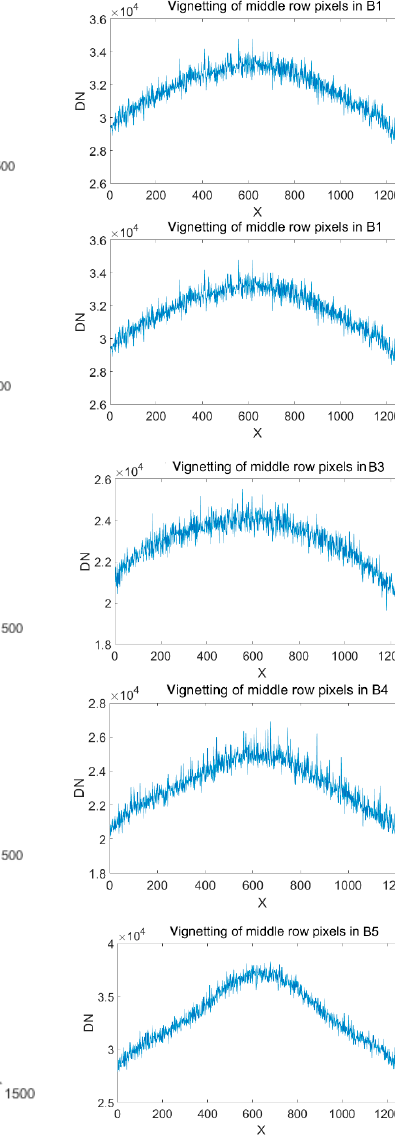
( e ) Figure 11. Comparison of middle row pixels between vignetting image and original image: ( a ) fitting performance of Band1; ( b ) fitting performance of Band2; ( c ) fitting performance of Band3; ( d ) fitting performance of Band4; ( e ) fitting performance of Band5.